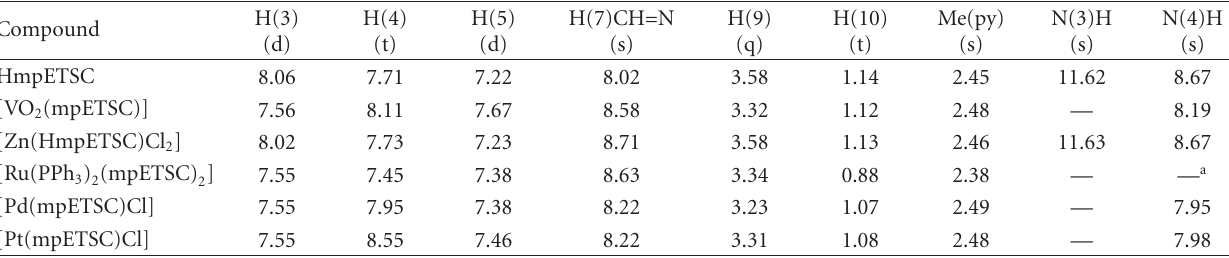
Table 3: 1 H-NMR spectral data of HmpETSC and its complexes.